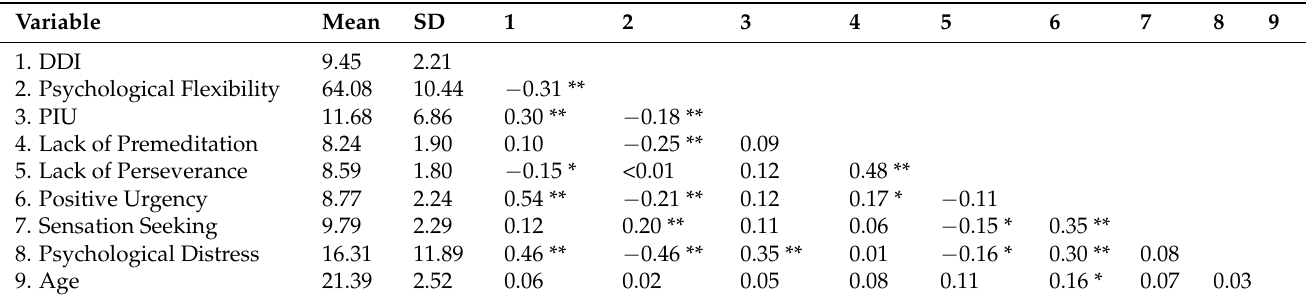
Table 1. Descriptive statistics and Spearman’s